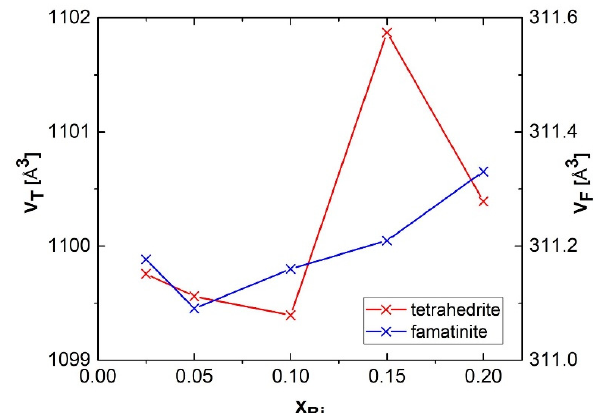
Figure 3. Unit cell volume of tetrahedrite Cu 12 Sb 4 S 13 , V T and famatinite Cu 3 SbS 4 , V F for sintered samples as a function of the nominal Bi content, X Bi